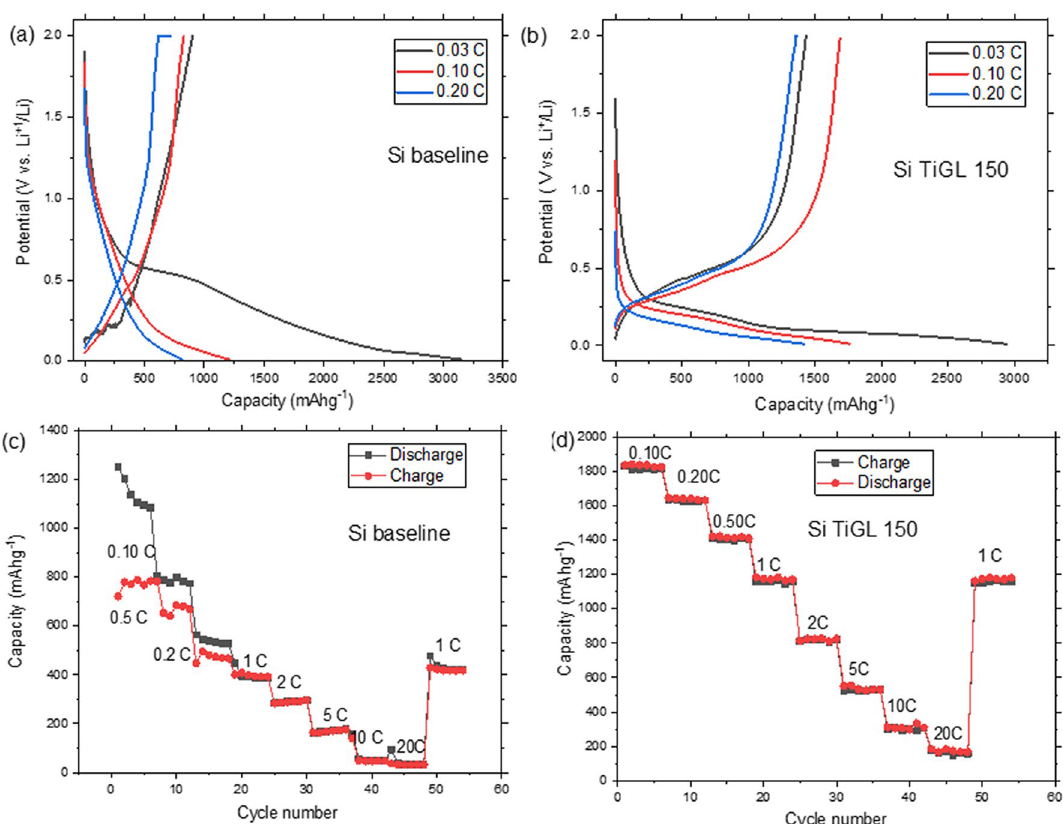
Figure 3. Electrochemical tests ( a ) and ( b ) charge/discharge profiles and ( c ) and ( d ) rate-capability tests for Si baseline and Si TiGL 150, respectively.